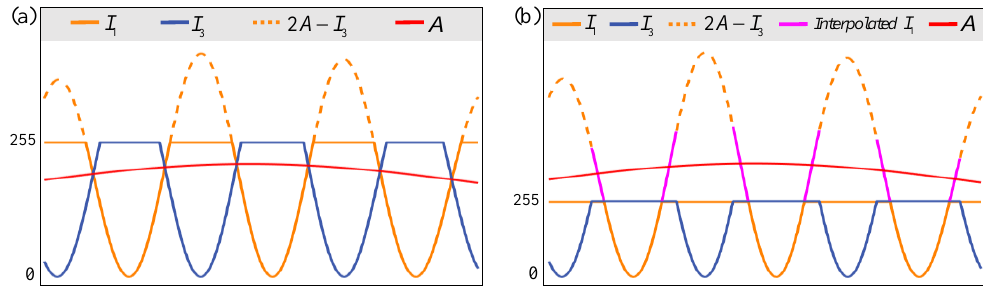
Figure 2. Two saturation fringe restoration strategies with different saturation. Assume that A is known in both scenarios. ( a ) A < 225, all saturated areas of I 1 can be restored through unsaturated areas of I 3 . ( b ) A ≥ 225, only a part of saturated areas of I 1 can be restored through unsaturated areas of I 3 , and the rest can be further obtained by interpolation.